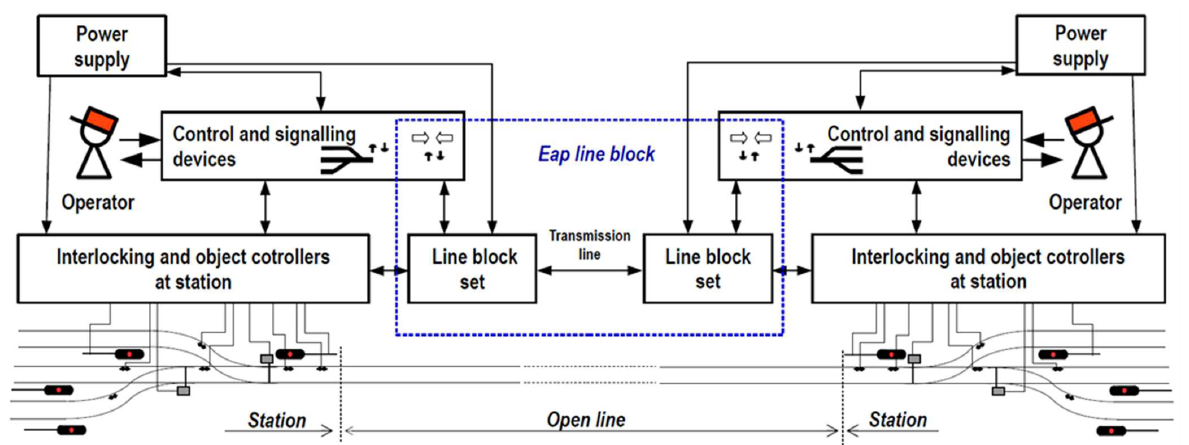
Figure 1. Illustrative diagram of the Eap line block and its